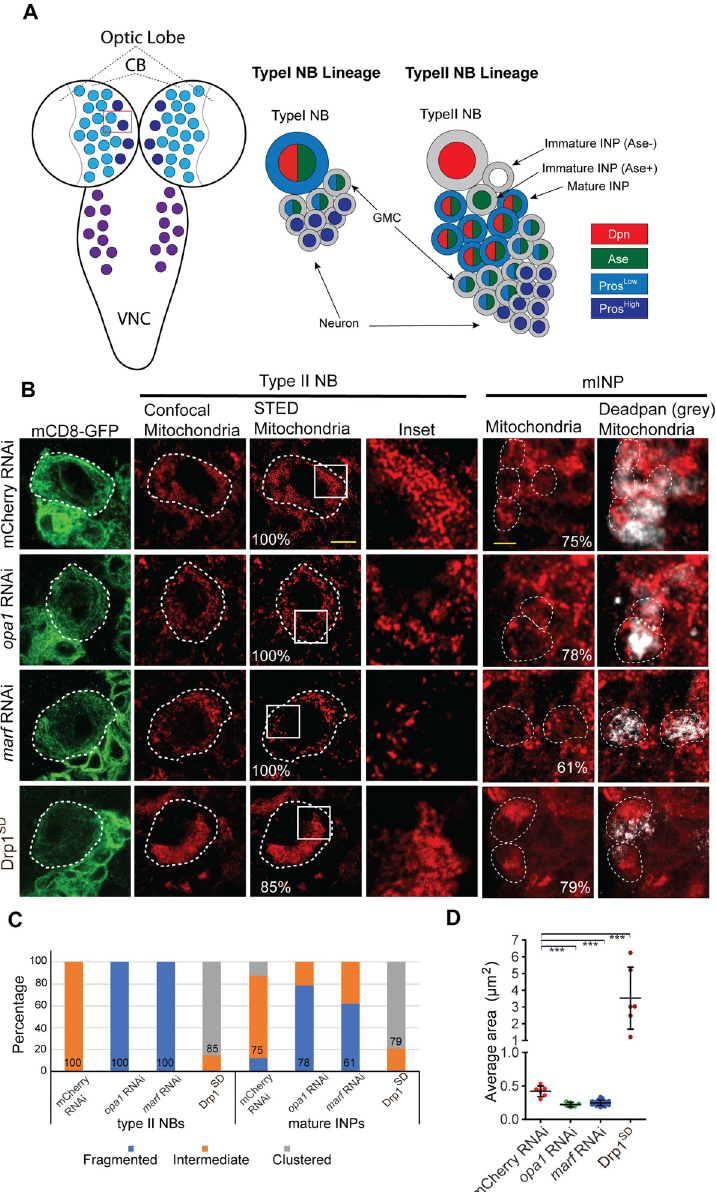
Fig 1. Opa1 and Marf depletion leads to fragmented mitochondria and overexpression of Drp1 SD leads to clustered mitochondria in type II NBs. A: Schematic of larval CNS (left) containing the central brain (CB) lobes and ventral nerve cord (VNC) and type I (blue) and type II NB (purple) distribution and lineages of type I (left) and type II NB (right). The type I NB lineage has nuclear Dpn (red) and Ase (green) and cytoplasmic Pros (light blue) expressing NBs, nuclear Ase (green) and Pros (light blue) expressing GMCs and high levels of nuclear Pros (dark blue) expressing neurons. The type II NB lineage has Dpn positive NBs (red nuclei), Dpn negative, Ase negative and Pros negative immature INPs (black and white), only Ase expressing immature INPs, nuclear Dpn (red) and cytoplasmic Pros (light blue) expressing mature INPs, nuclear Ase and Pros expressing GMCs (green nuclei) and high levels of nuclear Pros (dark blue) expressing young neurons. B-D: Mitochondrial morphology and distribution in type II NBs expressing pnt -Gal4, mCD8-GFP (white dotted line, magnified area shown in the panel on the right) stained with ATP β (red) antibody using confocal imaging and STED super resolution microscopy is shown in representative single optical plane images with zoomed inset in the right panel (B). Single plane confocal images from mature INPs from each image are marked with Dpn and stained with mito-GFP (red). mCherry RNAi (32 type II NBs, 8 brains: 100% intermediate morphology; 40 mature INPs, 5 brains, 8 lineages, 75% intermediate, opa1 RNAi (46 type II NBs, 8 brains: 100% fragmented; 47 mature INPs, 3 brains, 9 lineages, 78% fragmented), marf RNAi (45 type II NBs, 8